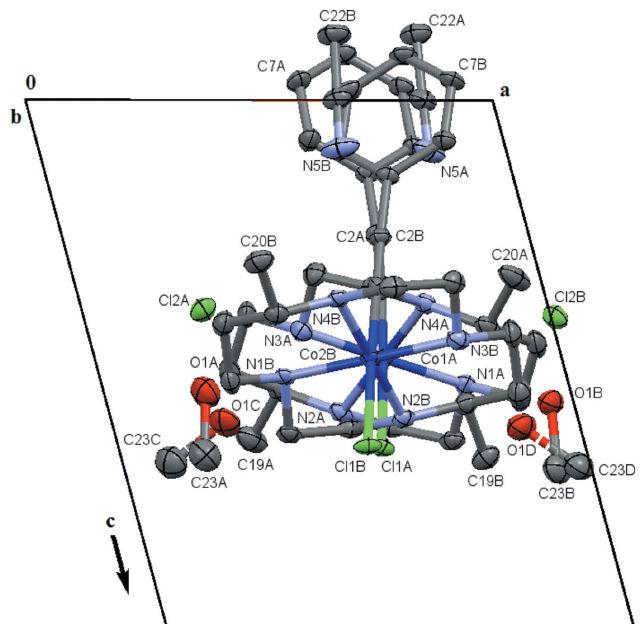
Figure 3 Displacement ellipsoid plot (set to a 20% probability setting for clarity) for compound 1 , showing the pseudo-glide plane perpendicular to the a axis. The shift direction is along b .